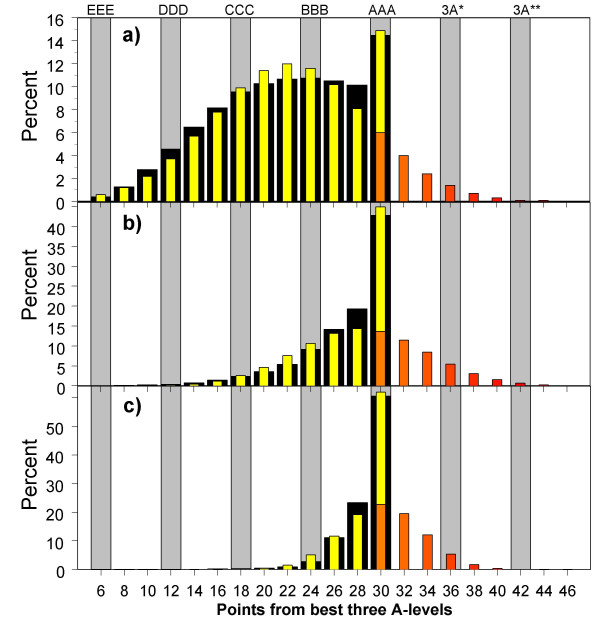
The black bars show the observed distributions of A-level grades attained by a) all UCAS applicants, b) all medical school applicants, and c) all medical school entrants. The yellow bars show the fitted distribution which has been estimated on the basis of a normal distribution which has been truncated at 6 points and censored at 30 points, with all individuals scoring more than 30 points being included in the 30 point bin. The orange bars show the proportions of individuals who would have been expected to gain 32, 34, 36 etc. points, where 36 points can be construed as three A* grades, 42 points three A** grades, etc..